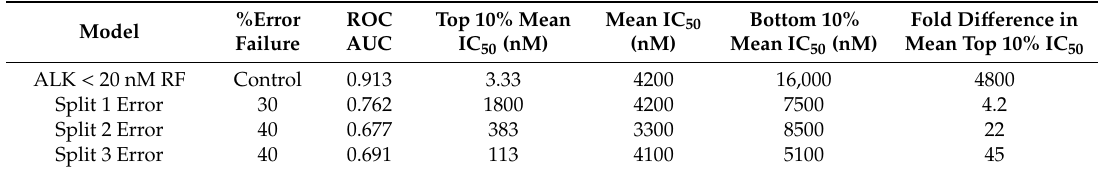
Table 5. Performance statistics for failed RFs generated with the specified error in each split.